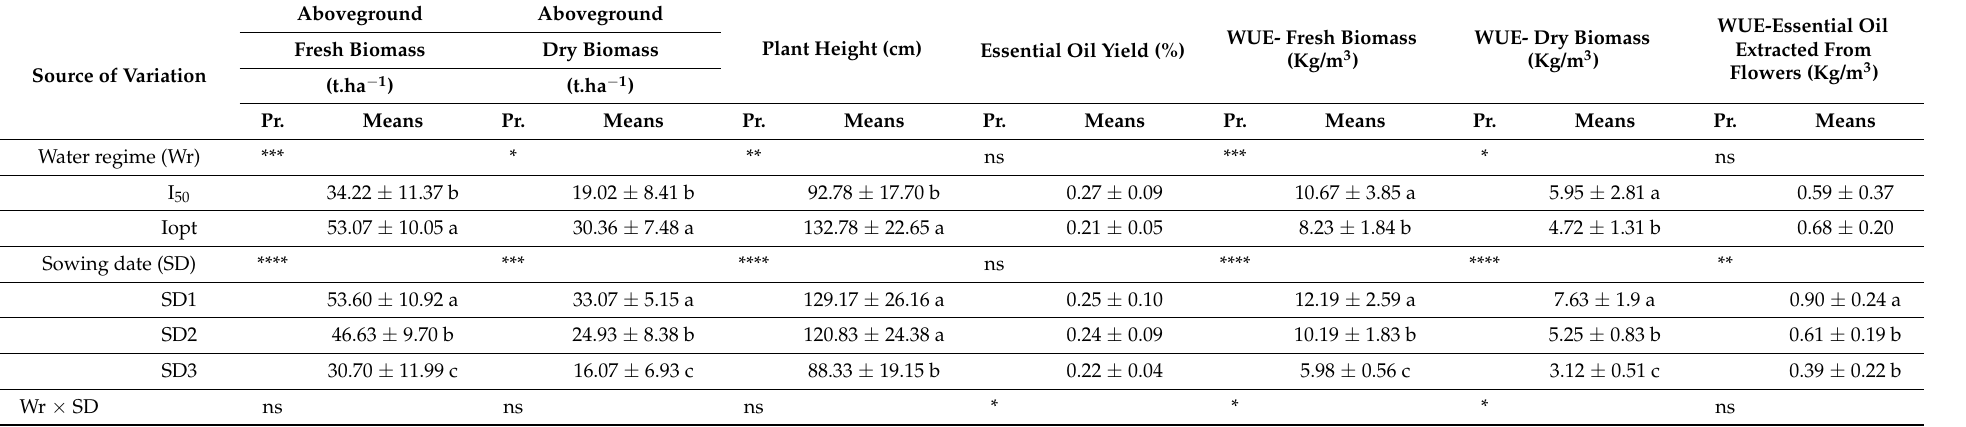
Table 1. The biometric and productive characteristics of cannabis as affected by water regime and sowing